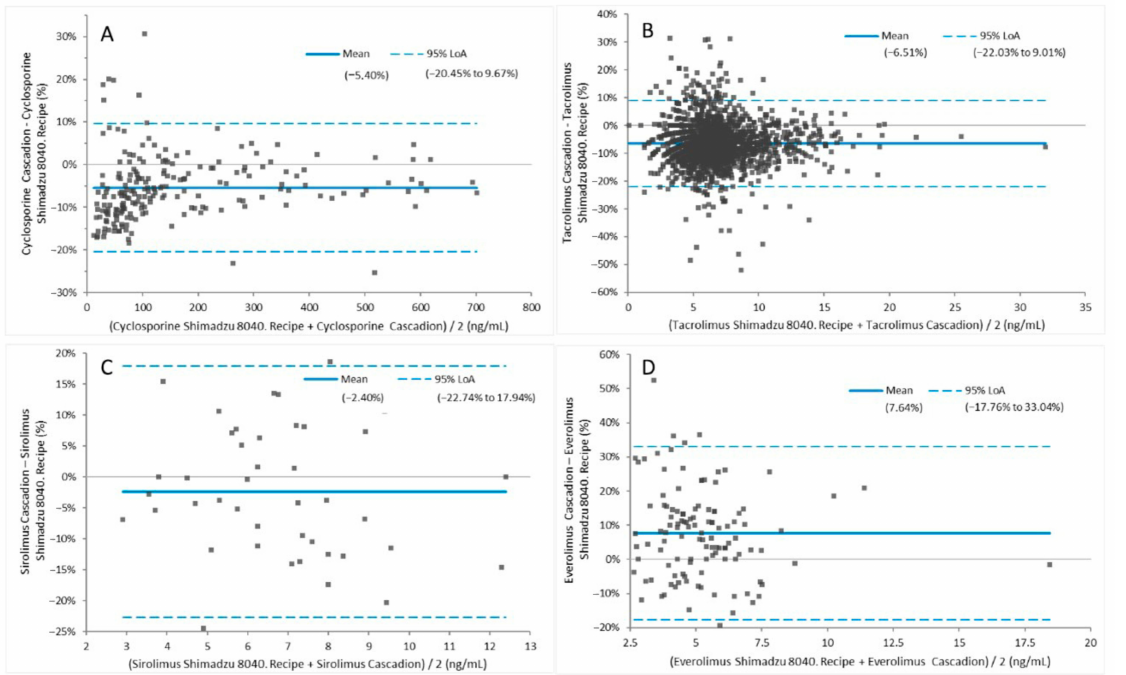
Figure 3. Bland − Altman plot for cyclosporine A ( A ), tacrolimus ( B ), sirolimus ( C ), and everolimus ( D ). In each plot, the mean and the limit of acceptance (LoA) are